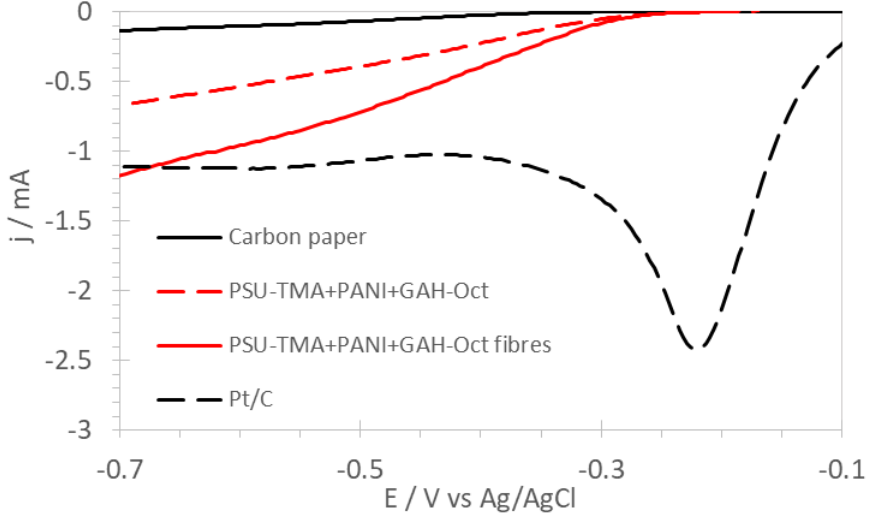
Figure 7. Linear sweep voltammograms of nanostructured electrodes of the ORR in O 2 -saturated 1 M KOH with RDE at 1500 rpm in comparison with commercial Pt/C foil.